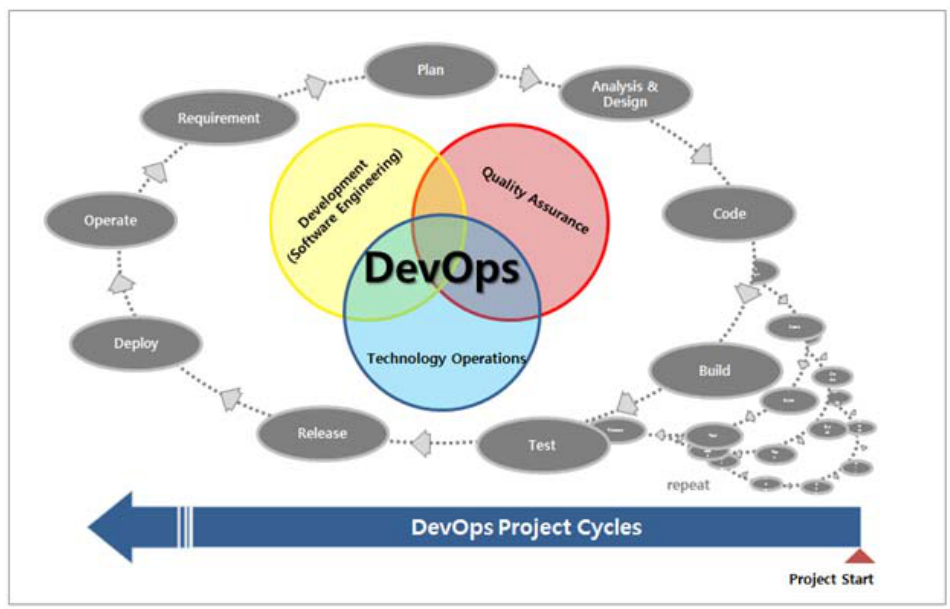
Figure 7. The operation cycle of a DevOps project.